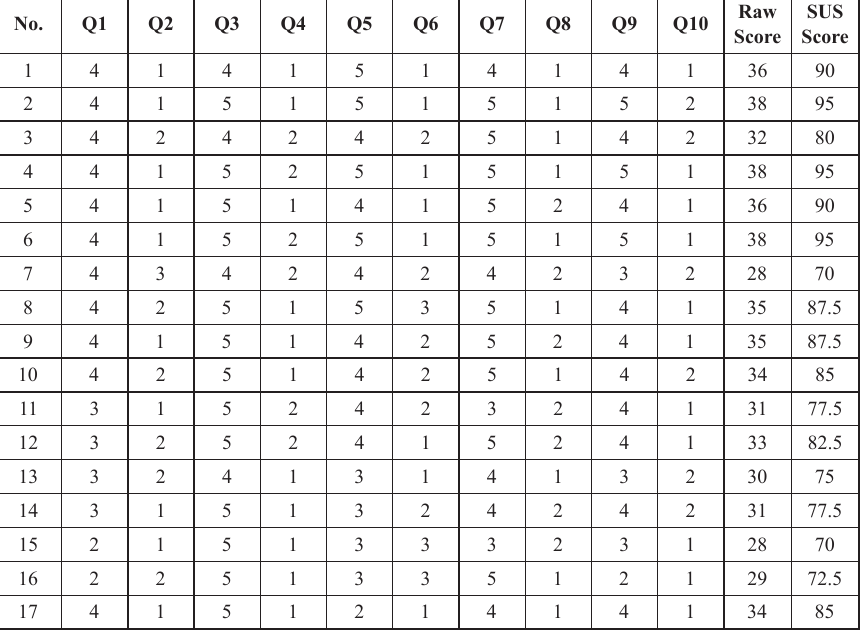
Table 1. System usability scale (SUS) questionnaire—responses